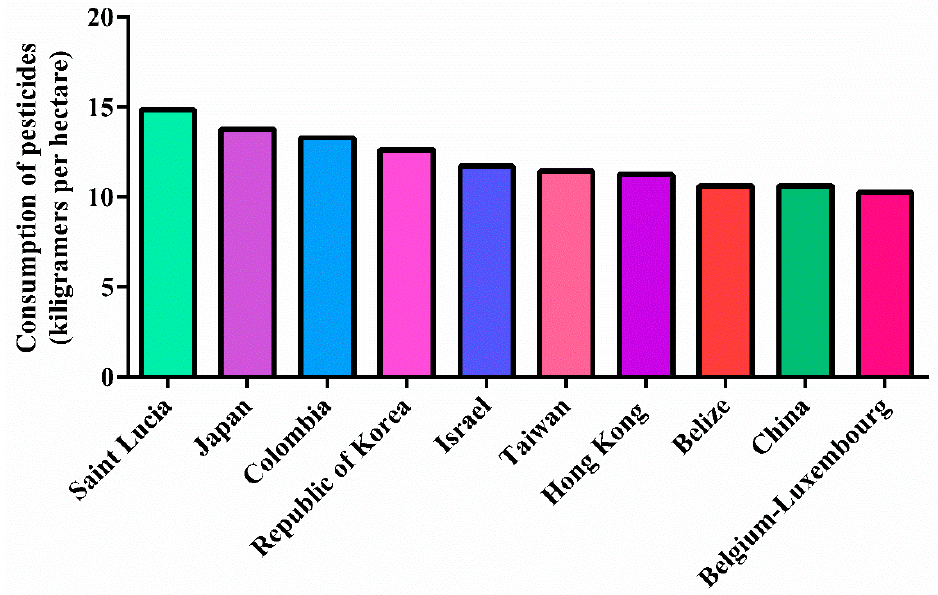
Figure 6. Kilograms of pesticides consumed by hectare in different counties, according to Food and Agriculture Organization of the United Nations.